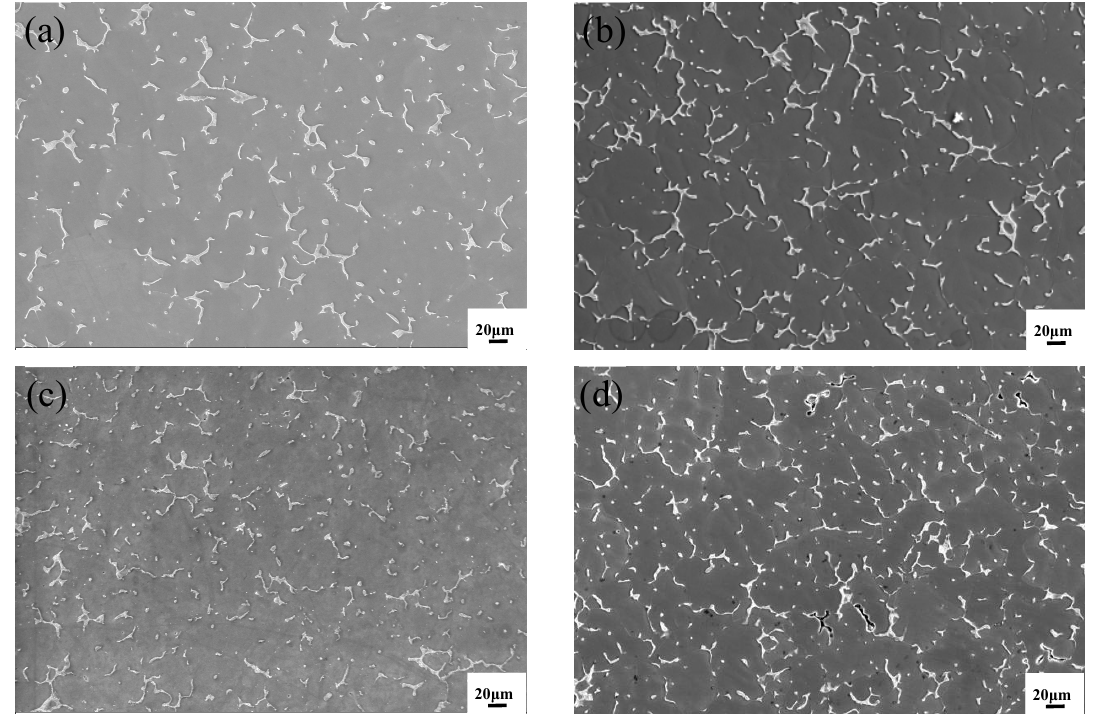
Figure 3. SEM (Scanning Electron Microscope) diagram of the cast state of ( a ) ZL205A alloy, ( b ) ZL205A + 0.1%La alloy, ( c ) ZL205A + 0.3%Al–5Ti–0.8C alloy, and ( d ) ZL205A + 0.1%La + 0.3%Al– 5Ti–0.8C alloy.